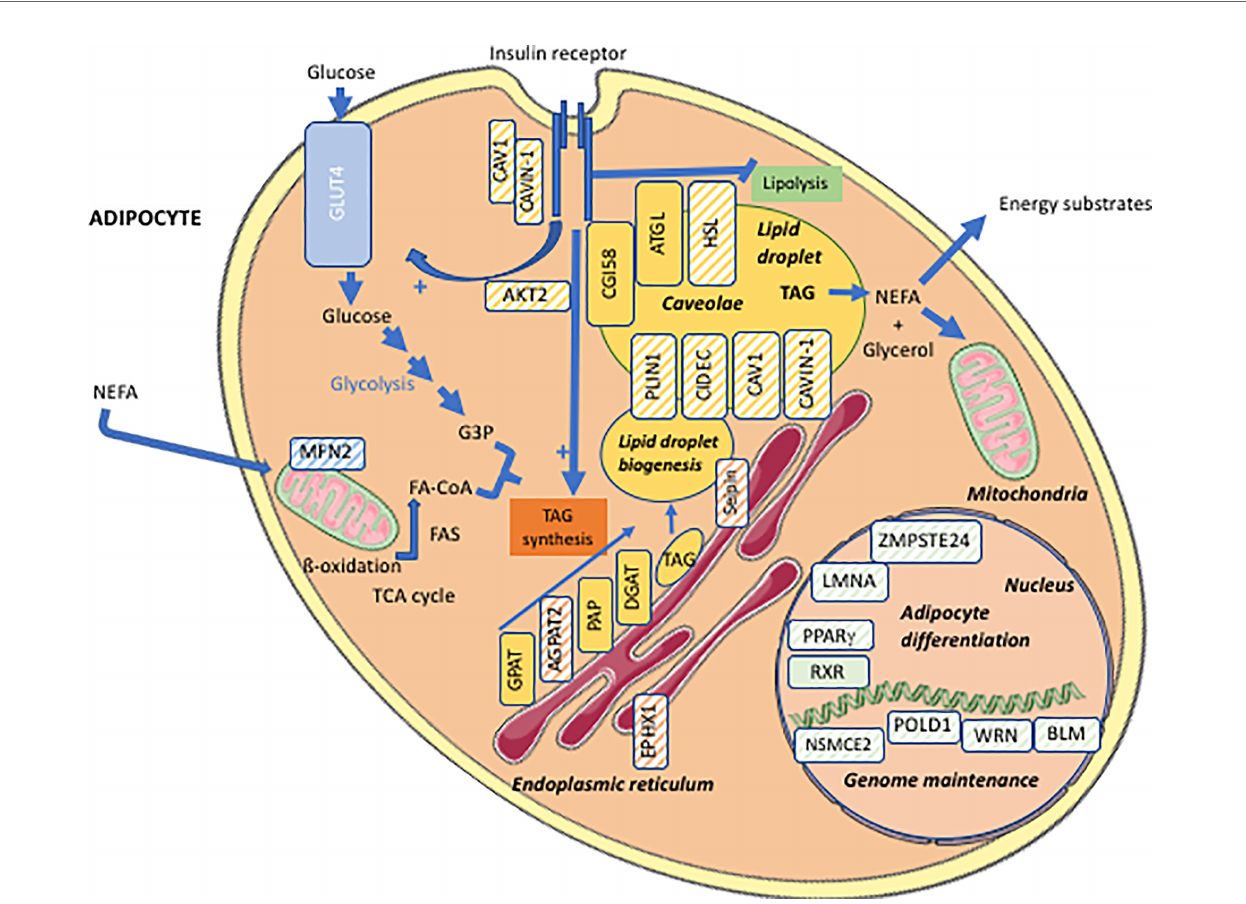
FIGURE 1 | Cellular targets of the main molecular defects responsible for lipodystrophy syndromes. Adipocyte schematic representation with localization of the main proteins involved in the molecular pathophysiology of lipodystrophy syndromes (hatched symbols). AGPAT2, 1-acylglycerol-3-phosphate-O-acyltransferase 2; AKT2, serine/threonine-protein kinase 2; ATGL, adipose triglyceride lipase; BLM, Bloom syndrome protein; CAV1, caveolin-1; CAVIN1, cavin-1; CGI58, comparative gene identi fi cation-58, also known as a / b -hydrolase domain-containing 5 (ABHD5); DGAT, diacylglycerol acyltransferase; EPHX1, epoxide hydrolase 1; FA, fatty acid; FA- CoA, fatty acid-coenzyme A; FAS, fatty acid synthase; G3P, glycerol-3-phosphate; GLUT4, glucose transporter 4; GPAT, glycerol-3-phosphate acyltransferase; HSL, hormone-sensitive lipase; LMNA, lamin A/C; MFN2, mitofusin-2; NEFA, non-esteri fi ed fatty acids; NSMCE2, E3 SUMO-protein ligase NSE2; PAP, phosphatidic acid phosphatase; PLIN1, perilipin-1; POLD1, DNA polymerase delta 1, catalytic subunit; PPAR g , peroxisome proliferator-activated receptor gamma; RXR, retinoid X receptor; TAG, triacylglycerol; TCA cycle, tricarboxylic acid cycle; WRN, WRN RecQ like